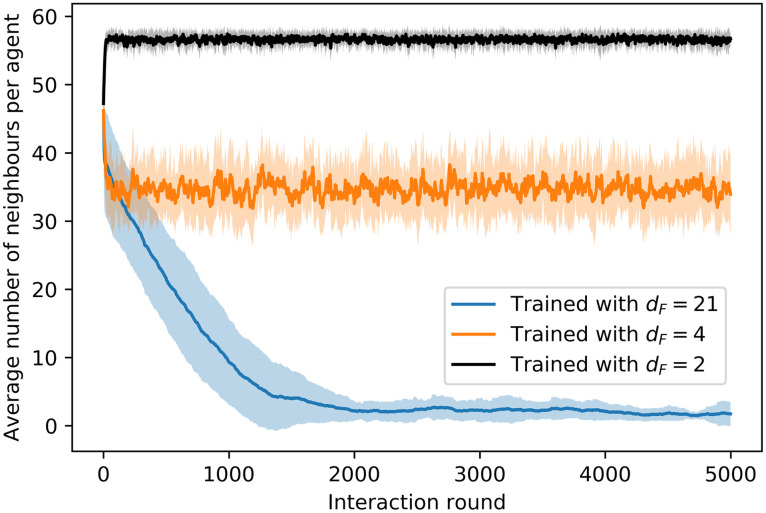
Evolution of the average number of neighbors throughout the trial of 5000 interaction rounds.Average is taken over 20 ensembles of 60 agents each, where for each ensemble the simulation is performed independently. Shaded areas indicates one standard deviation.